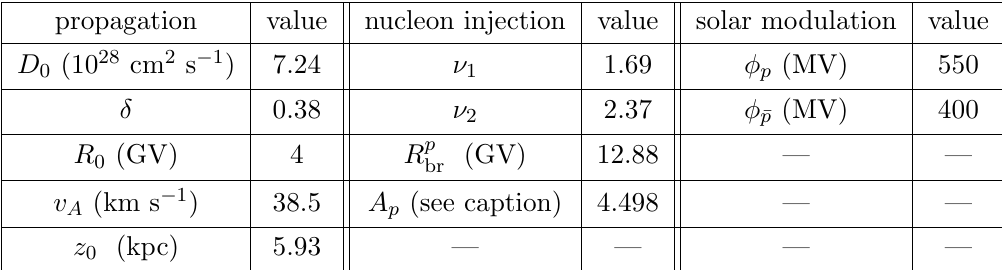
Table 2 . Parameters of propagation, nucleon injection and solar modulation and their values adopted in our numerical analysis. The proton (cid:13)ux is normalized to A p at 100 GeV in the units of 10 (cid:0) 9 cm (cid:0) 2 s (cid:0) 1 sr (cid:0) 1 MeV (cid:0) 1